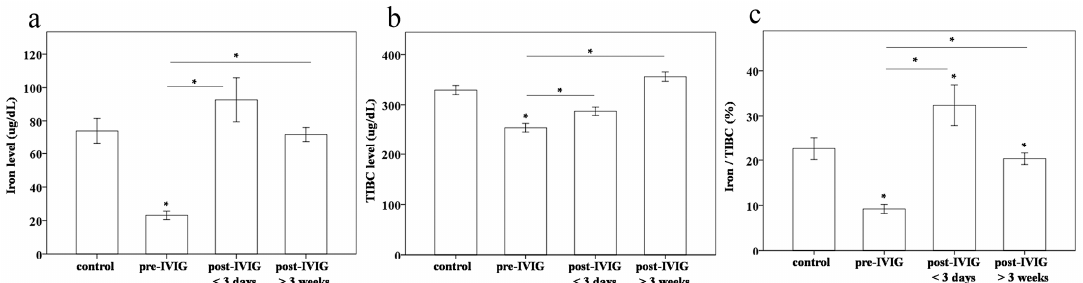
Figure 2. Comparison of ( a ) iron levels; ( b ) total iron binding capacity (TIBC); and the ( c ) iron/TIBC ratio between controls ( N = 20) and patients with Kawasaki disease (KD) ( N = 20) before and after undergoing intravenous immunoglobulin (IVIG) treatment Data are presented as mean ± standard error. * indicates p < 0.05 between the control and KD groups.